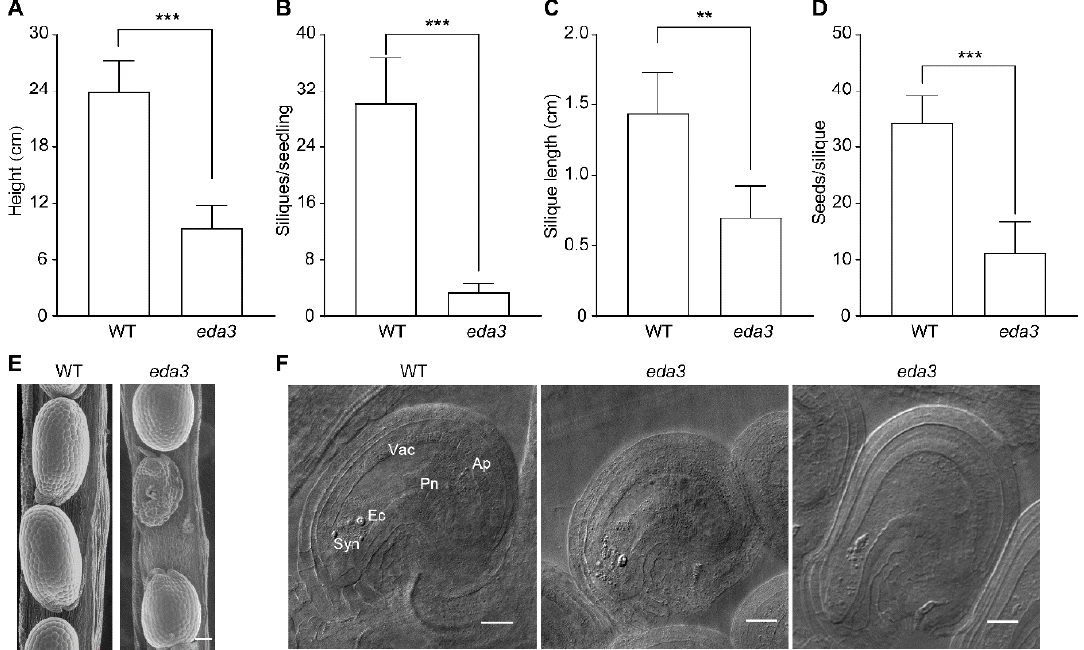
Figure 2. Phenotype of the Arabidopsis thaliana eda3 mutant. ( A ) Heights of the seedlings; ( B ) Numbers of siliques per seedling; ( C ) Length of siliques; ( D ) Numbers of seeds per silique, were measured in the wild-type (WT) and eda3 mutant seedlings. Seedlings for each line were cultivated under normal growth conditions. For ( A ) and ( B ), 6-week-old seedlings were measured. For (C) and (D), mature (brown) siliques were used for measurements. Data represent means ± SEM ( n = 3). Asterisks indicate significant differences between the indicated lines (** p < 0.01, *** p < 0.001, Student’s t -test). ( E ) SEM observation of mature siliques of WT and eda3 . Bar = 100 μm; ( F ) Microscopic observation of the embryo sacs of the WT and eda3 plants. Vacuole (Vac), synergid (Syn), egg cell (Ec), polar nuclei (Pn), antipodal cells (Ap) are indicated. Bar = 20 μm.